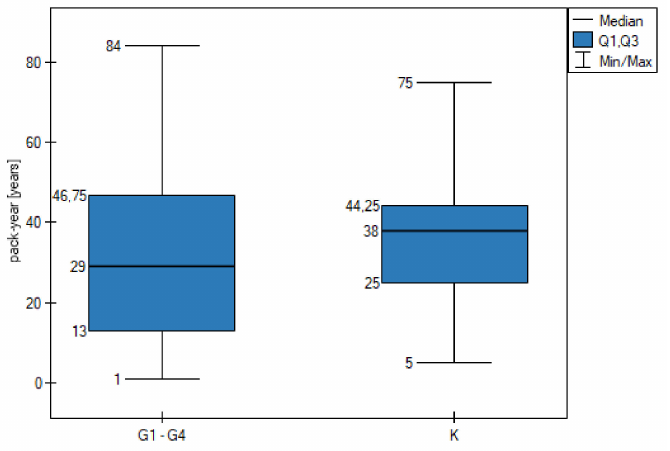
Figure A3. Comparison of the patient population and the control group in relation to